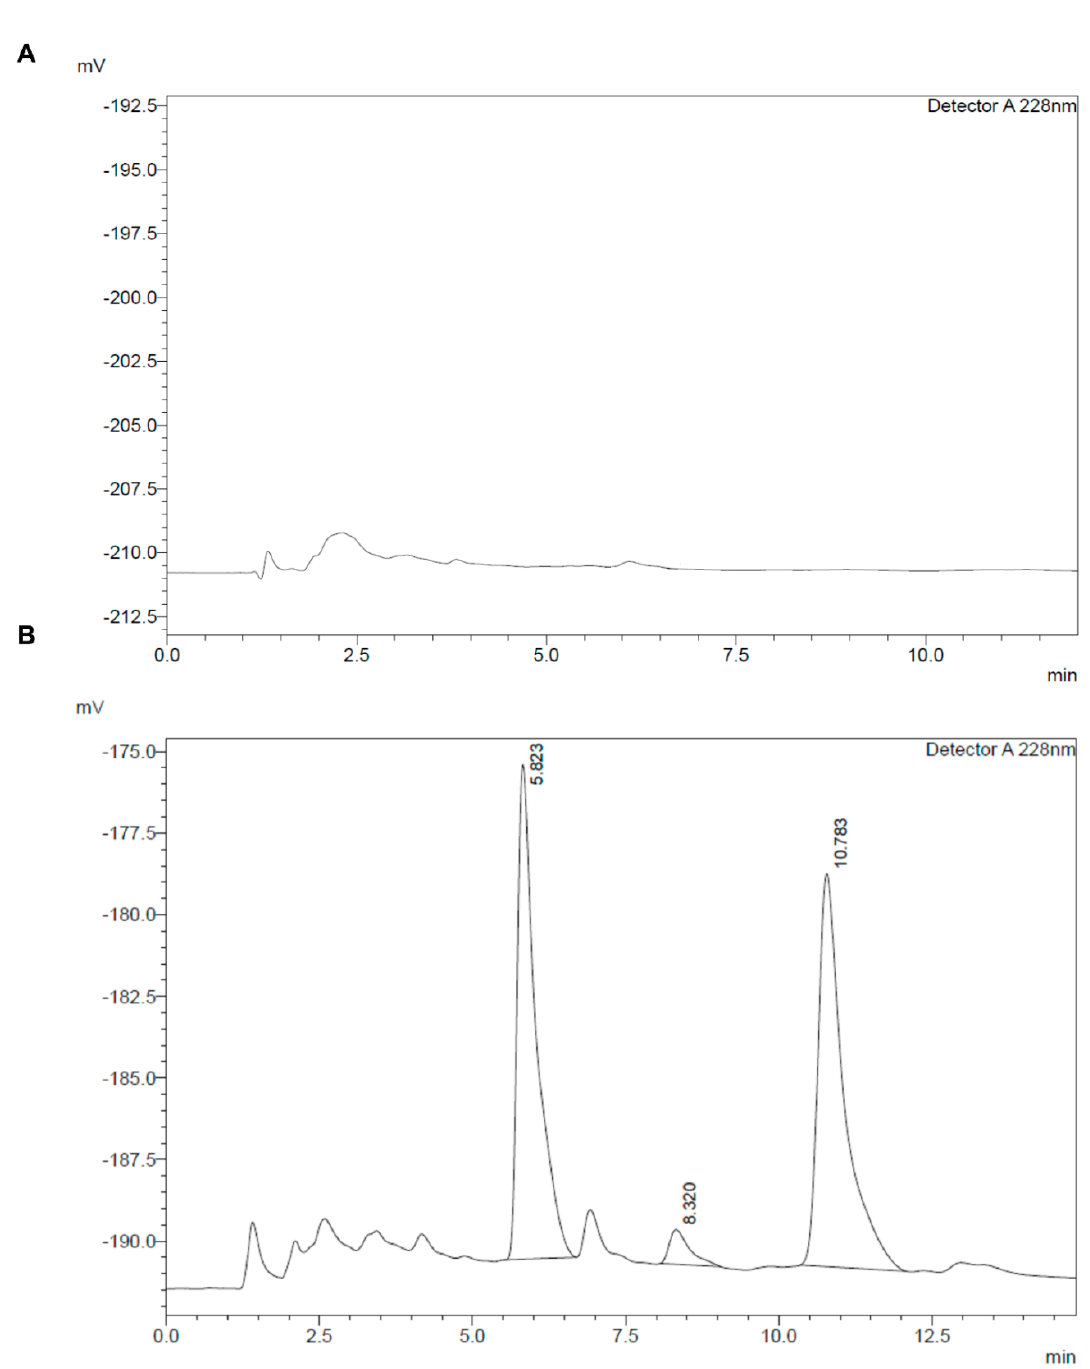
Figure 2. ( A ) A chromatogram of blank plasma; ( B ) a chromatogram of a human plasma sample spiked with 20 ng/mL